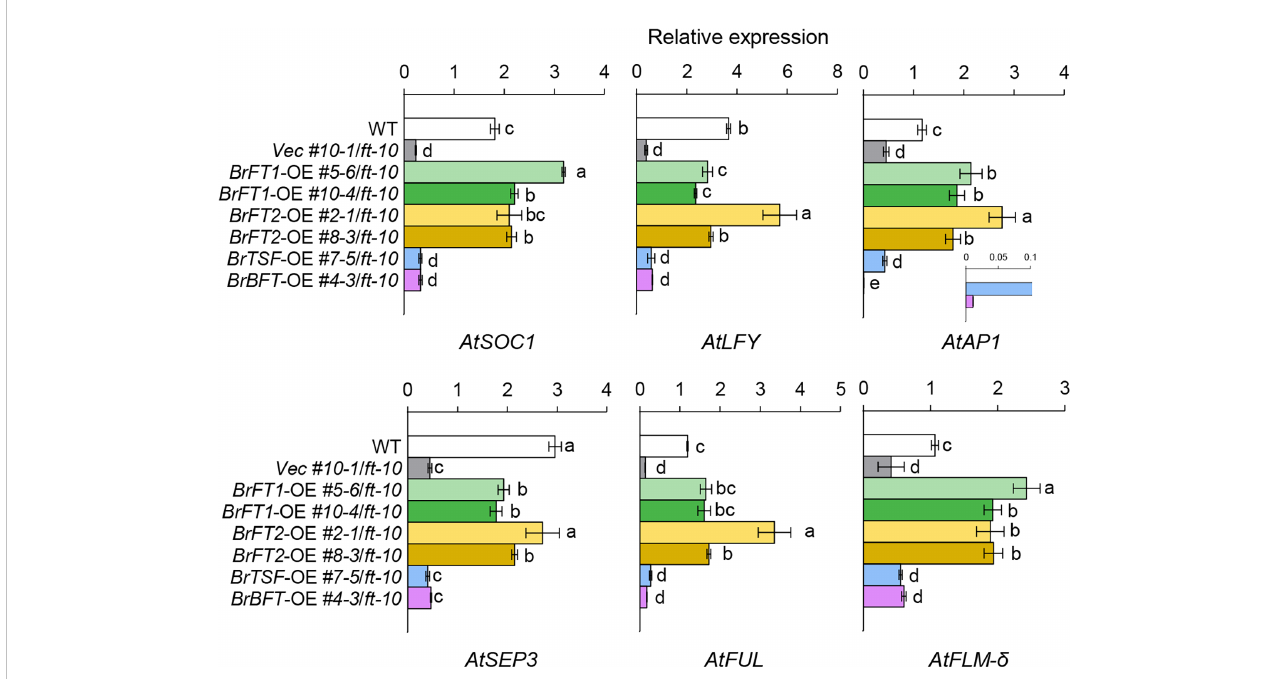
FIGURE 3 RT-qPCR analysis of fl owering time genes in lines overexpressing BrFT-lik e genes in Arabidopsis. This analysis was done on the leaf samples from the same location grown for 2 weeks. Gene expression levels were normalized to AtACT2 as a reference. Data are means ± SE of three biological replicates. Different lowercase letters represent signi fi cant differences, as determined by one-way ANOVA followed by Tukey ’ s post-hoc test ( P <